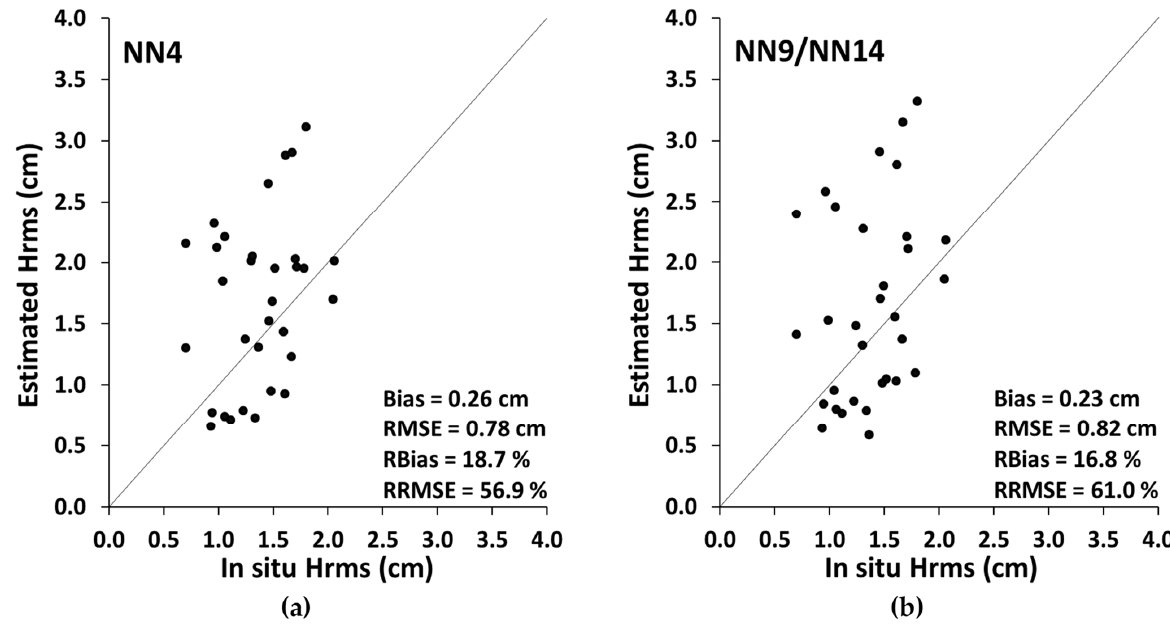
Figure 9. Retrieved Hrms using real SAR data in the L-band versus in situ measurements. ( a ) NN without a priori information on SSM (NN4); ( b ) NN with a priori information on SSM in the dry to slightly wet soil conditions (NN9) and NN with a priori information on SSM in very wet soil conditions (NN14).